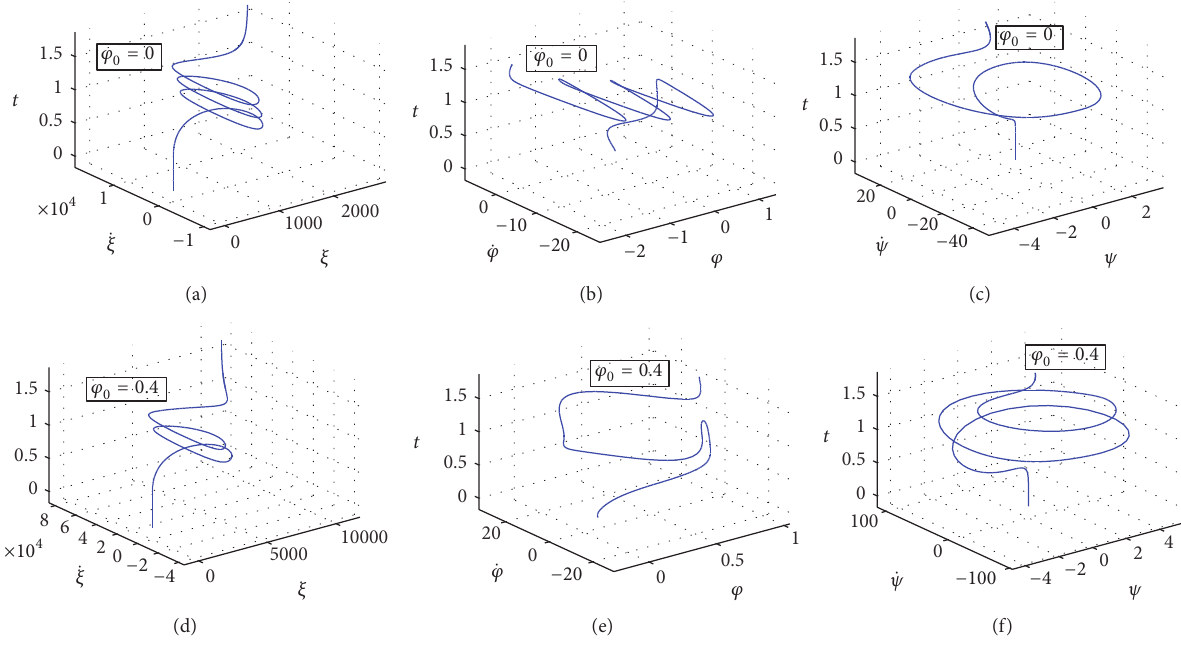
̇𝜉 versus 𝑡 when 𝜑 0 = 0 and 𝜑 0 = 0.4 rad,